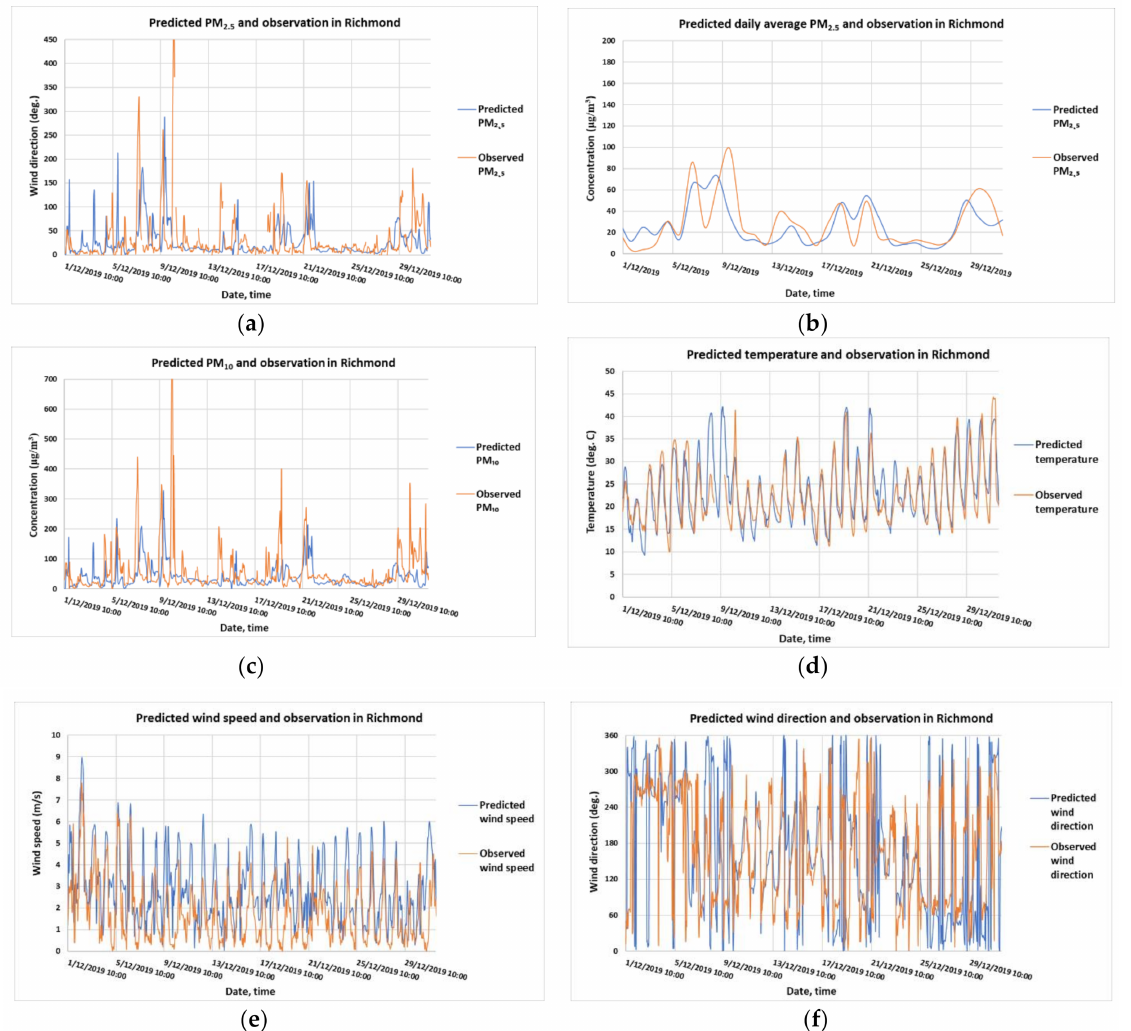
Figure A4. Predicted and observed hourly PM 2.5 ( a ), daily average PM 2.5 ( b ), hourly PM 10 ( c ), temperature ( d ), wind speed ( e ) and wind direction ( f ) at Richmond in the north west of Sydney in December